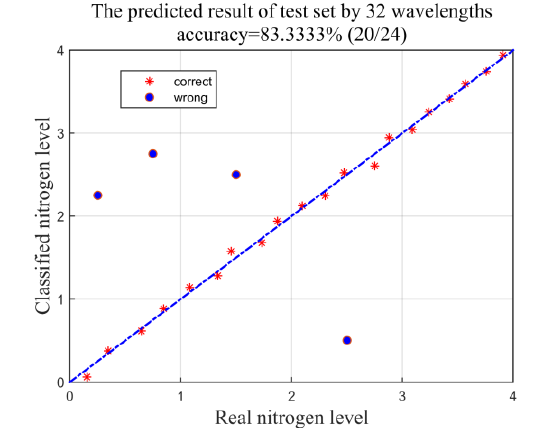
Figure 2 The real and classified nitrogen levels by using